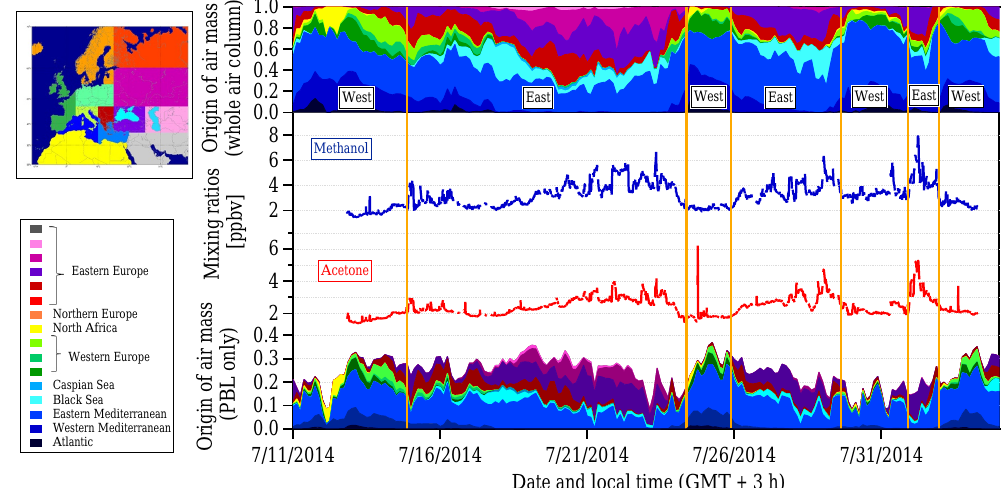
Figure 6. Allocation of Europe into specific regions (upper left panel) as well as traces of methanol and acetone in ppbv (10min mean values) and modeled data of the area of influence, given in fractions of 1. The upper part of the right panel refers to the whole air column, while the lower part of the right panel represents the PBL